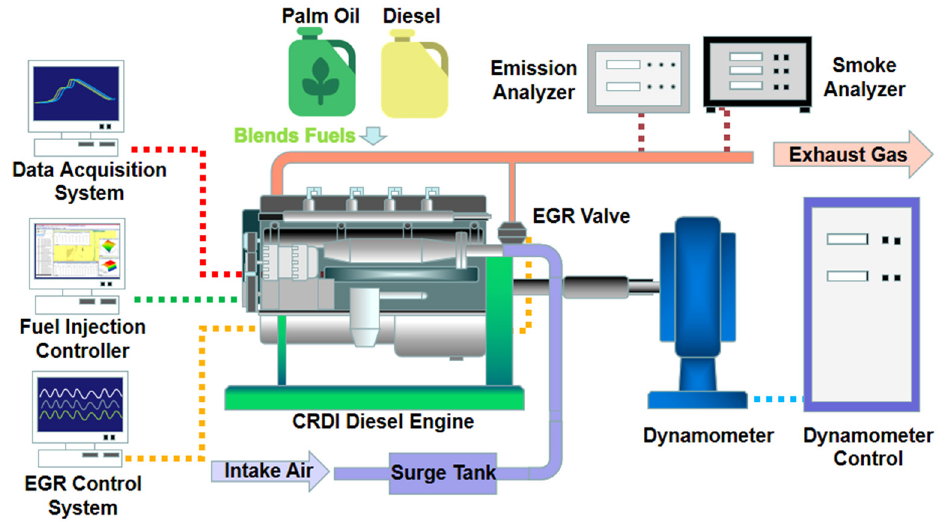
Figure 1. Engine test system. Table 2. Engine specifications. Table 3. Test and operating conditions.